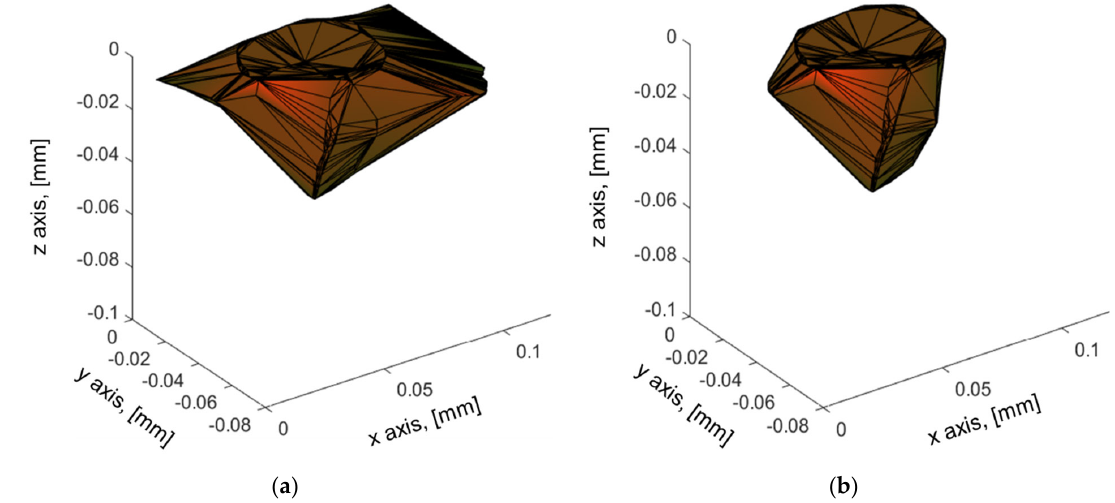
Figure 9. Three ‐ dimensional imaging of microstructure. ( a ) 3D image of #1 including layer ‐ 8; ( b ) 3D image of #1 except Figure 9. Three-dimensional imaging of microstructure. ( a ) 3D image of #1 including layer-8; ( b ) 3D image of #1 layer ‐ 8. except